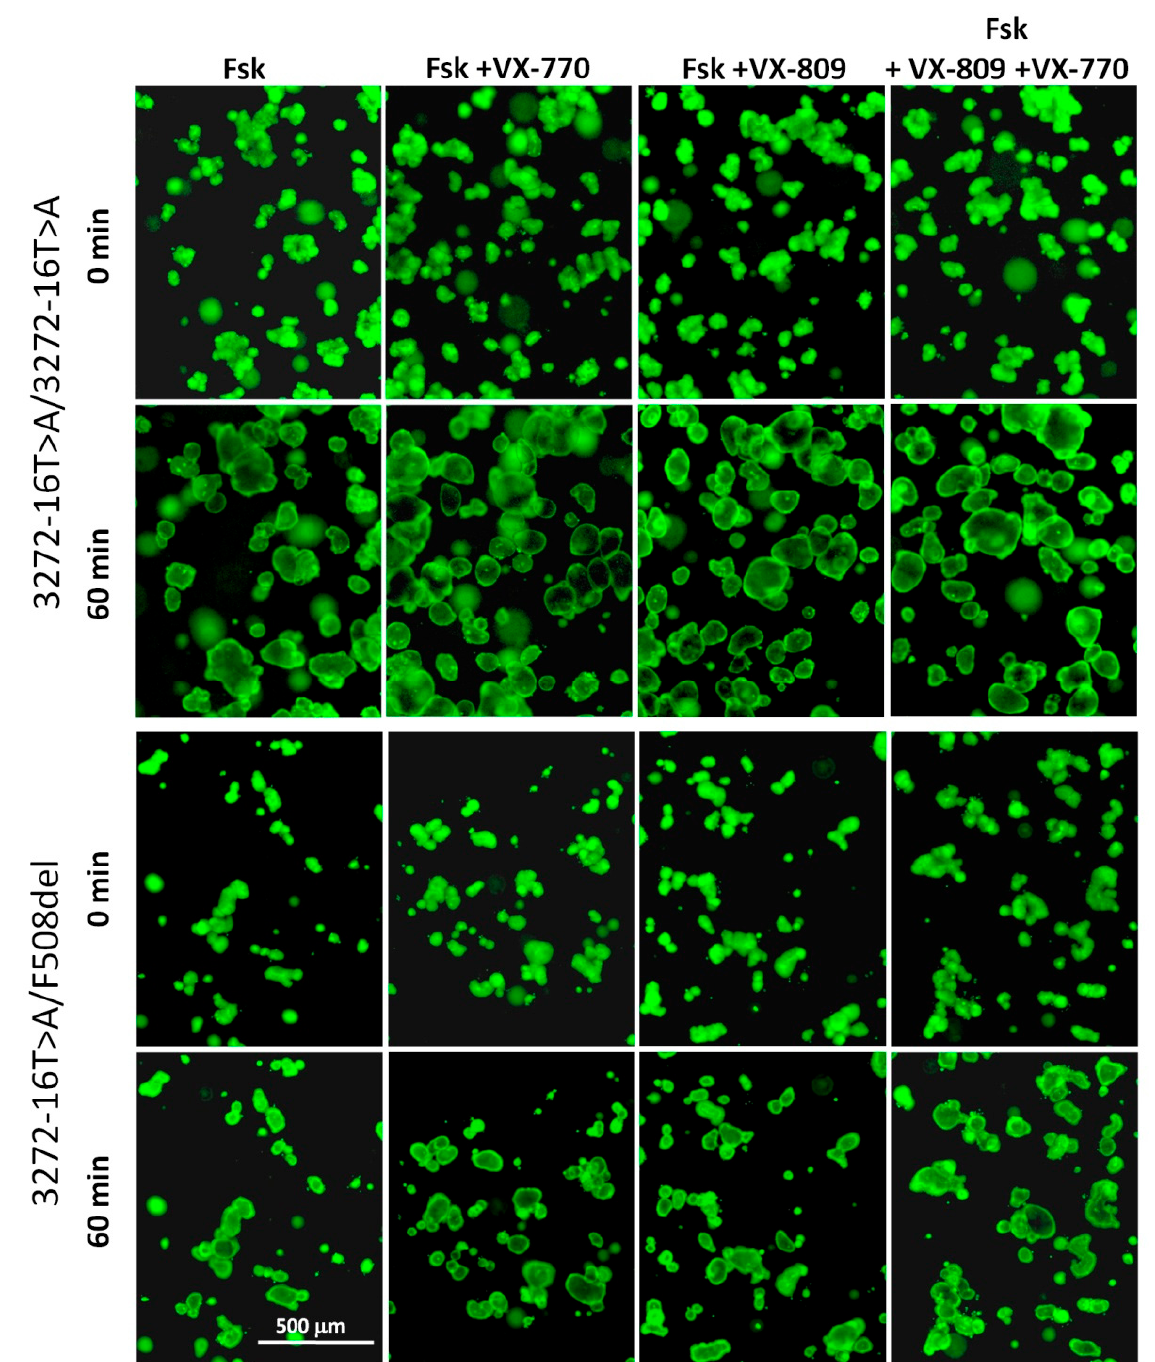
Figure 3. Characteristic images of intestinal organoids with genotypes c.3140-16T>A/c.3140-16T>A and c.3140-16T>A/F508del before exposure to forskolin (fsk; 5 μ M) and targeted drugs (both 3.5 μ M) and after treatment. Staining-Calcein (0.84 μ M, 1 h); objective ×5, scale-500 microns.